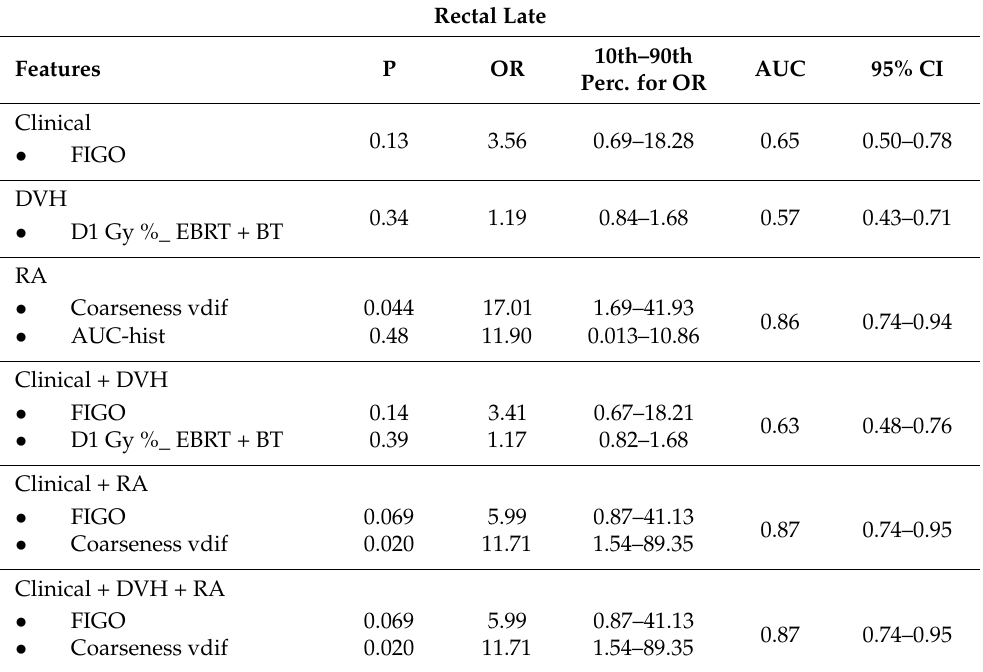
Table 4. Results of the multivariate logistic analysis for late rectal